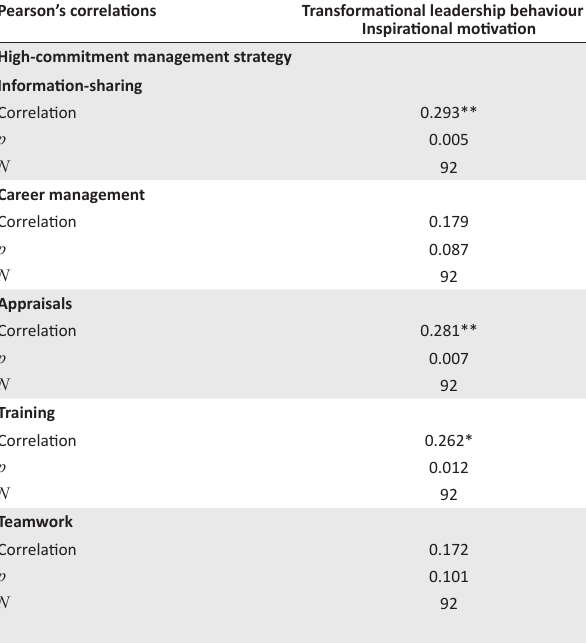
TABLE 3: Correlations of transformational leadership behaviour – Individualised TABLE 2: Correlations of transformational leadership behaviour – Inspirational consideration and high-performance management strategy. motivation and high-commitment management strategy. Pearson’s correlations Pearson’s correlations Transformational leadership behaviour – Inspirational